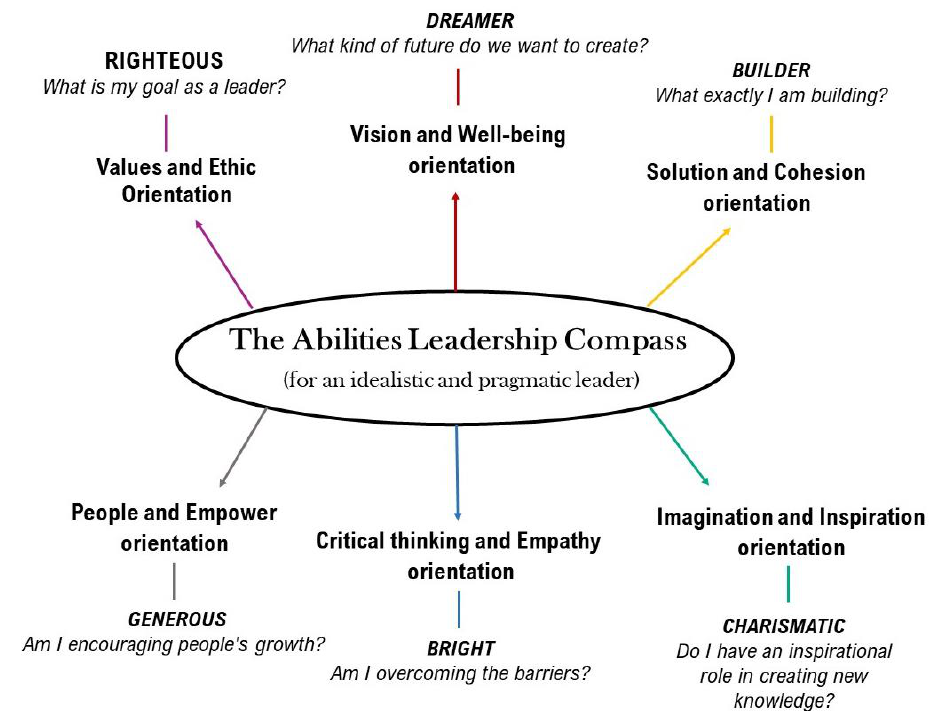
Figure 1. The Digital Transformative Leadership Compass. Source: own illustration of the authors.